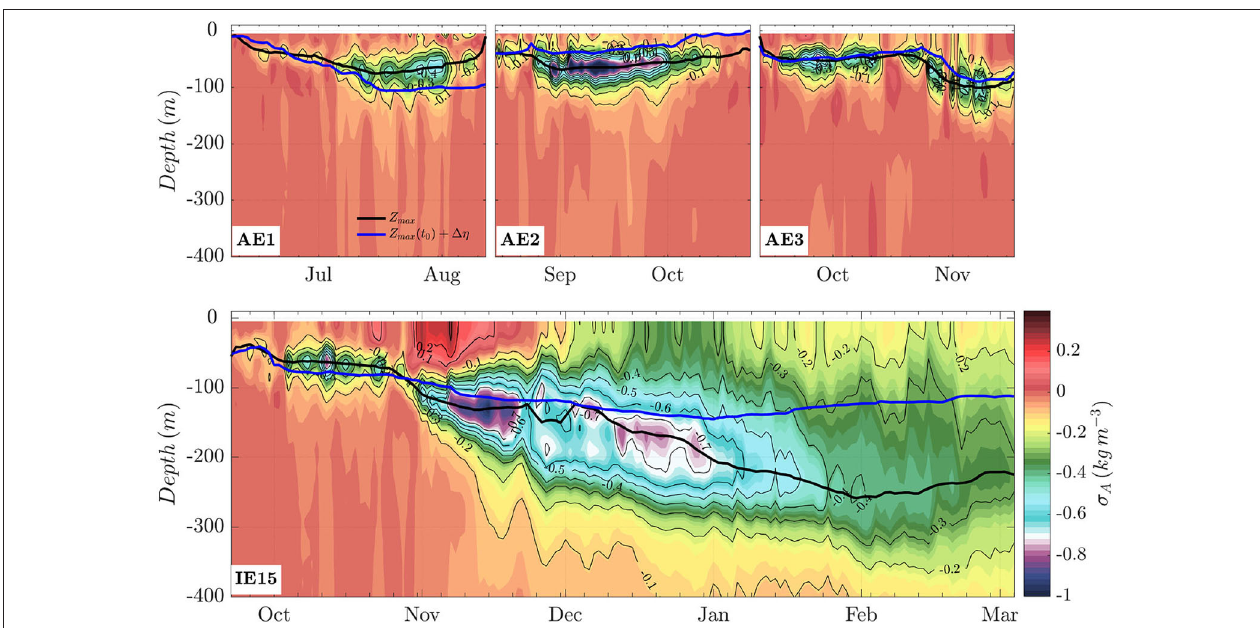
FIGURE 11 | Comparison between the vertical profiles of density anomaly σ A ( kgm − 3 ) for the AE1, AE2, AE3, and M_IE15 anticyclones generated during summer and fall period in the CROCO-MED60v40-2015 simulation southeast of Crete. The temporal evolution of the minimum density anomaly Z max and the isopycnal displacement 1η associated with the wind stress curl above the eddies are illustrated with the black and blue lines, respectively.